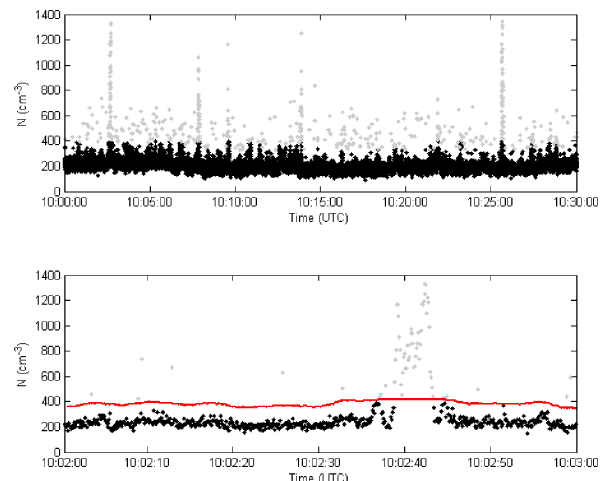
Fig. 4. A 30min section of the aerosol number concentration (cm − 3 ) (0.12 <R 80 < 9.25) time series (top) and a closer view of 1min of data (bottom) from the deployment on 31 March. Grey points are the selected whitecap plumes; black points show the am- bient background concentration. The red line depicts the threshold.